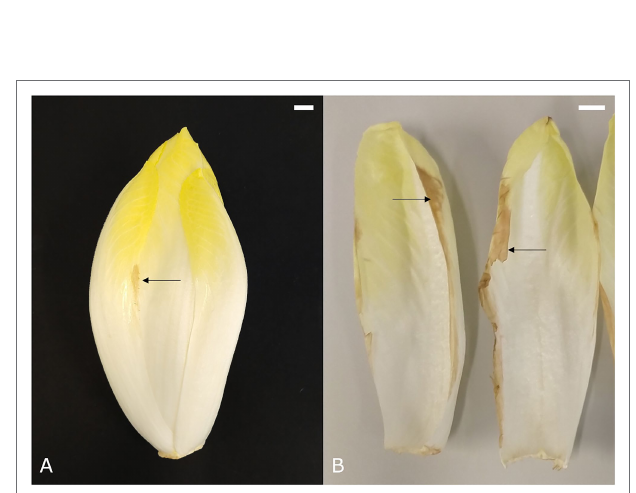
FIGURE 3 | Symptoms of (A) mild and (B) severe leaf edge browning of the external leaves. Scale bars represent 1